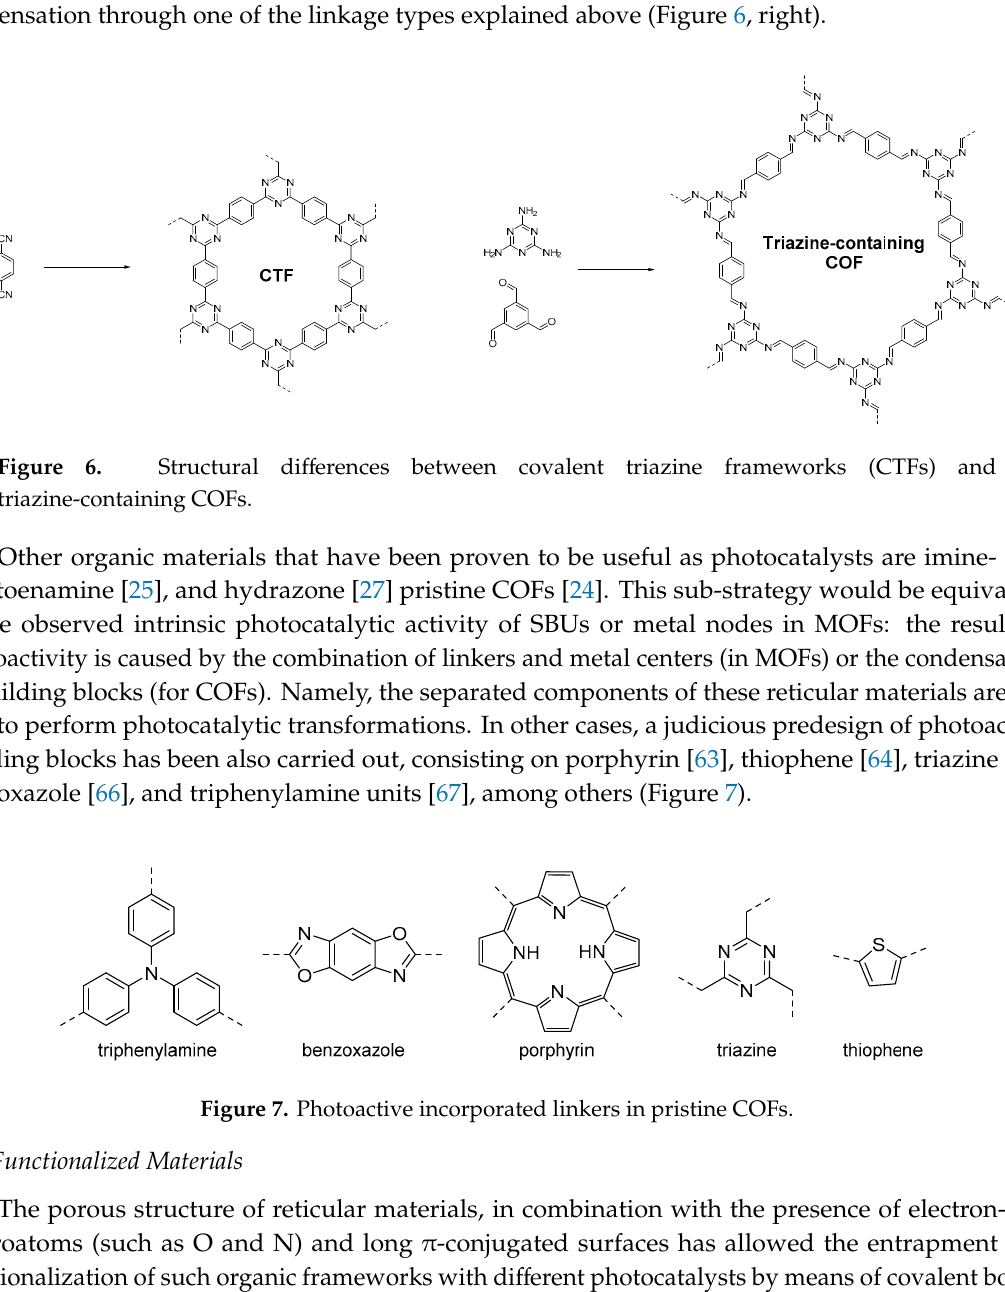
Figure 8. Photosensitizers employed in the functionalization of MOFs.